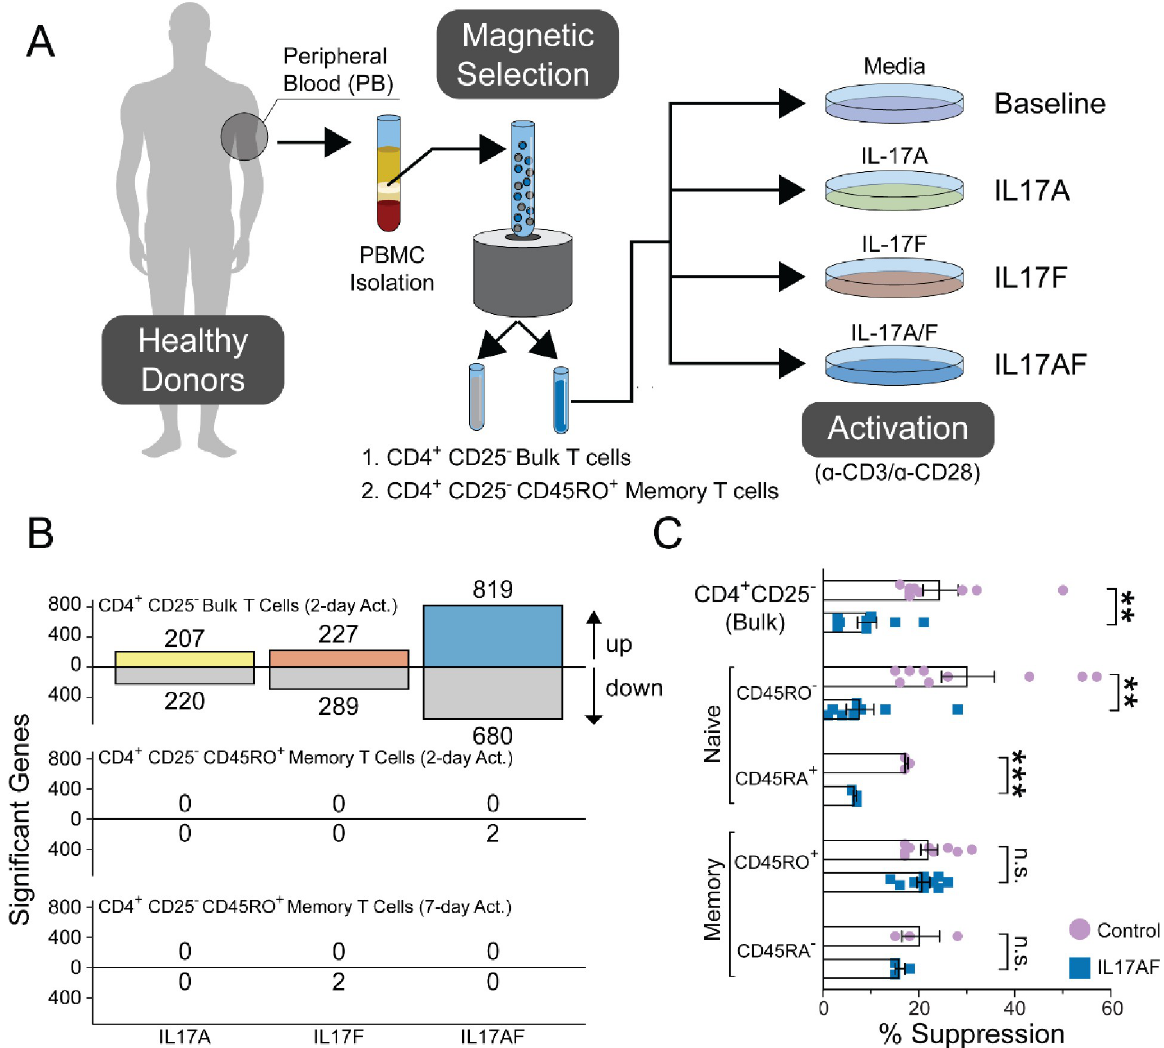
Fig 1. IL-17 cytokines affect na ï ve and bulk CD4 + T-cells but show no effect on memory T-cells. A . Schematic summary of the ex vivo treatment of bead-sorted bulk or memory CD4 + CD25 - T-cells activated in media alone (control/baseline), IL-17A, IL-17F, or IL-17AF heterodimer. After activation, RNA was isolated and underwent mRNA sequencing. B. The number of significant genes upregulated and downregulated with IL-17A (yellow), IL-17F (orange) and IL-17AF (blue) within the indicated populations. Significance was defined as q- value < 0.05 and log2-fold change > 1 or < -1. C. Negatively selected CD4 + 25 - T-cells were further sorted using either CD45RO or CD45RA magnetic beads resulting in bulk, na ï ve and memory T-cell populations, which were α CD3/ α CD28-activated for 7 days in media alone (control) or in the presence of IL-17AF and then used as responder cells in flow cytometric suppression assays with autologous CD8 + T-cells as suppressors. ** p < 0.005, *** p < 0.001, n.s. = not significant by Paired Student T-test. (CD45RO or CD45RA) or the positive/negative isolation (bead touched/untouched) status, we found that bulk and na ï ve CD4 + T-cells attained significant suppressive resistance following IL-17 exposure (Fig 1C). The memory cells were unaffected by this exposure, functionally cor- roborating the transcriptome data. Thus, IL-17 cytokines consistently induced functional changes in the na ï ve CD4 + T-cell subset but did not affect memory CD4 + T-cells.